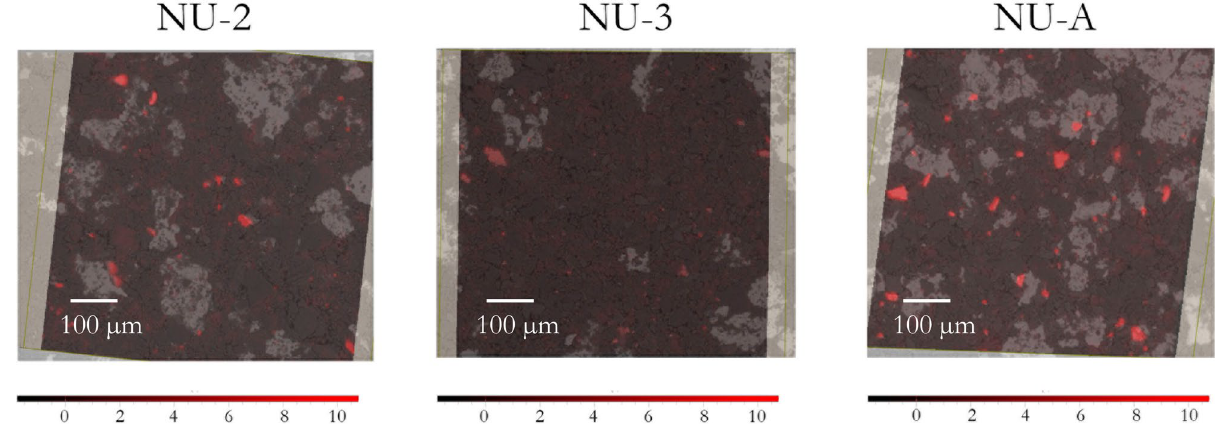
Figure 4. Superposition of Fe-S cluster distribution (red particles) and SEM image of NU-2, NU-3, and NU-A